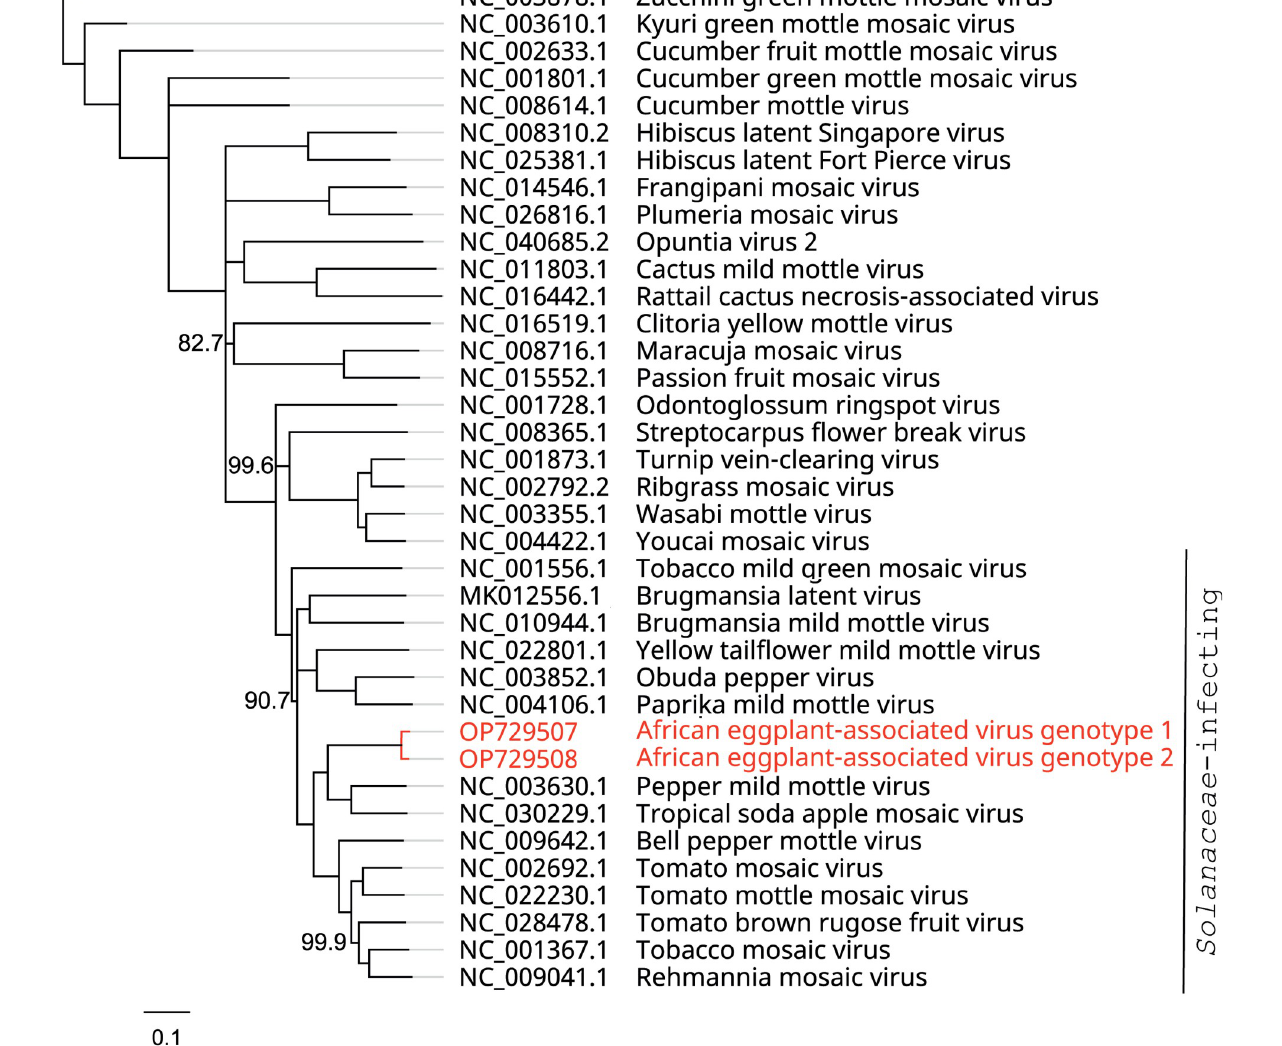
Fig 2. Unrooted neighbor-joining tree with (near) complete nucleotide sequences of the novel virus (red) and other members of the genus Tobamovirus including their GenBank accession numbers. The bar represents 0.1 substitutions per site. This tree was constructed by the neighbor-joining algorithm in Geneious software, using the genetic distance model Tamura-Nei, with 1,000 bootstrap replicates and the support threshold set at 70%. Support values (%) that were less than 100% are indicated next to the supported internal branches.